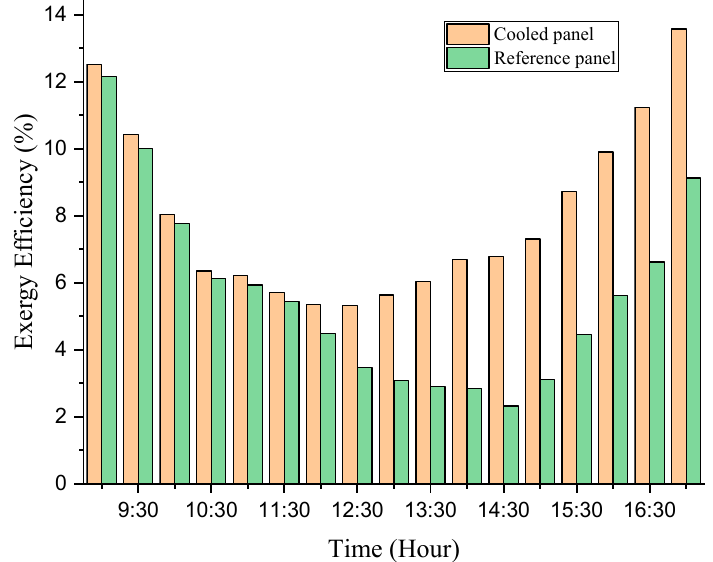
Figure 12. Exergy efficiency of both modules with time.